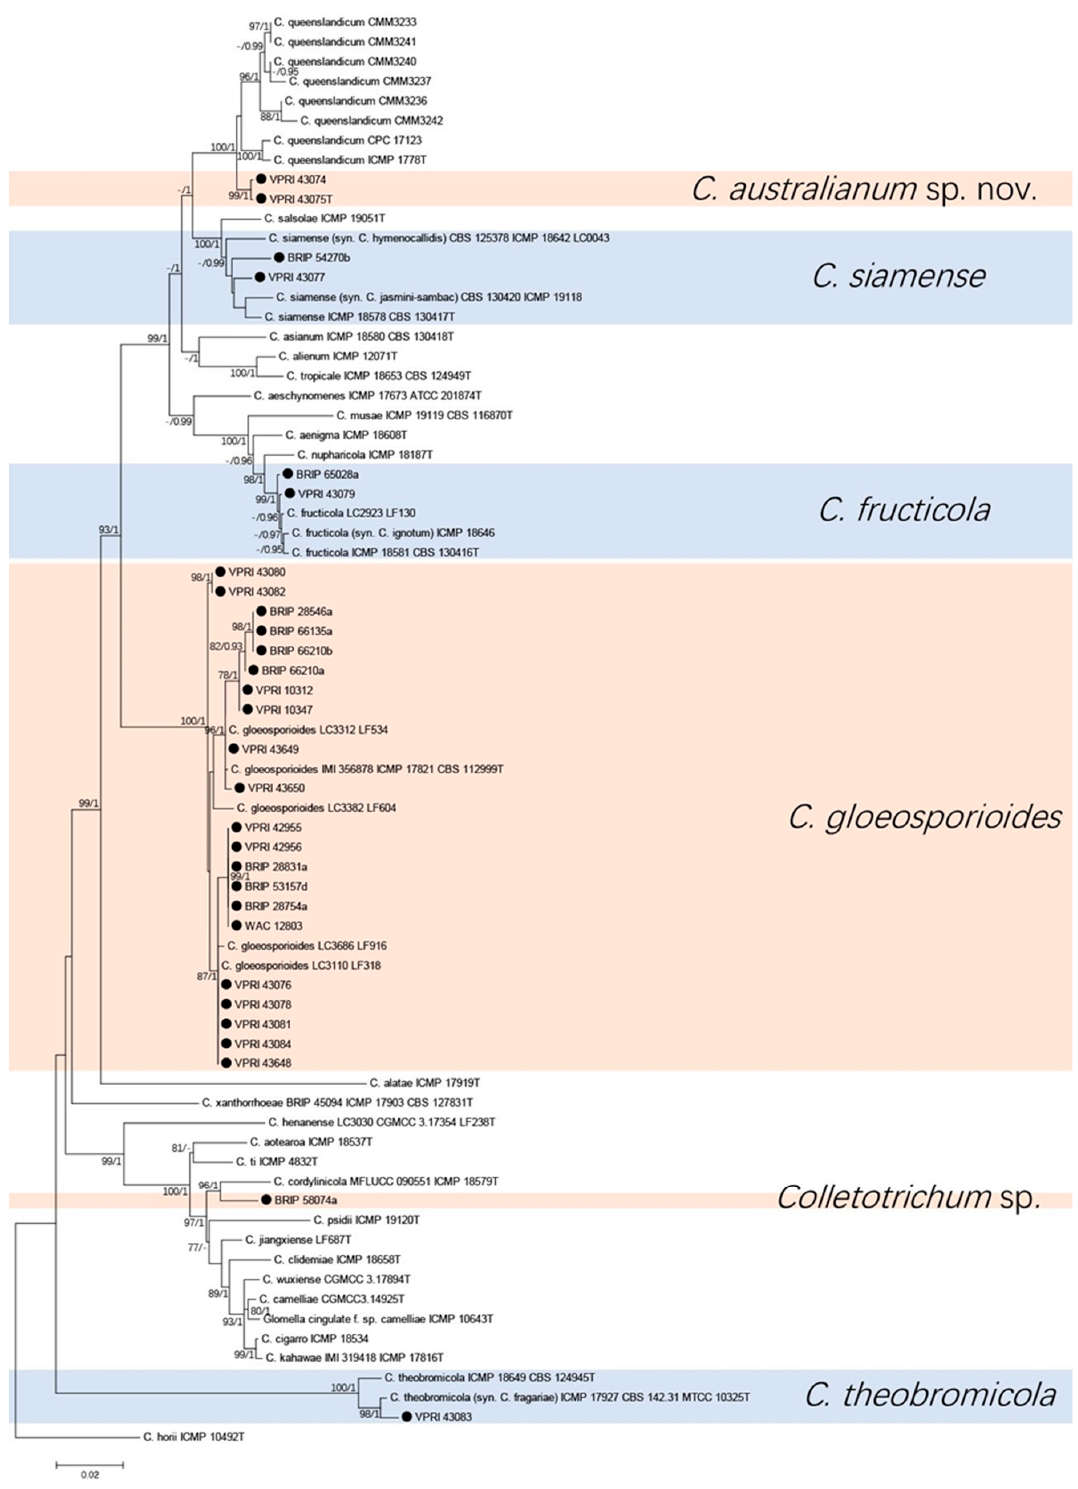
Figure 2. Phylogenetic analysis of the combined ApMat and GS sequence alignment of Colletotrichum isolates in the gloeosporioides complex. The bootstrap support values (ML > 75%) of maximum likelihood analysis and Bayesian posterior probabilities (PP > 0.90) are displayed at the nodes (ML/PP). Black circle denotes isolates from Citrus